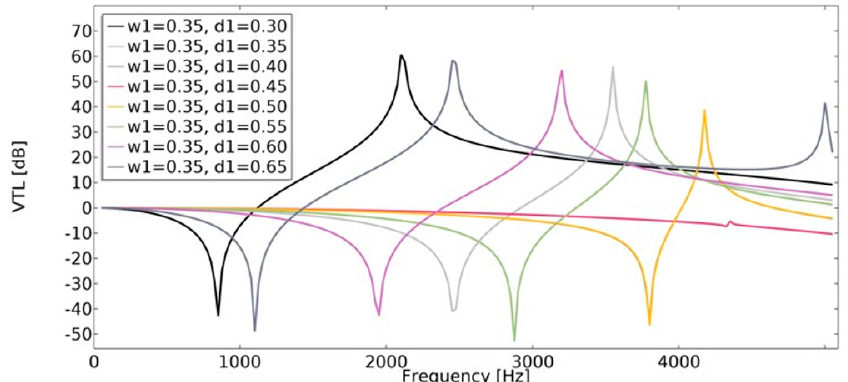
Figure 22. The influence of geometric features on the value of VTL for w 1 = 0.35.